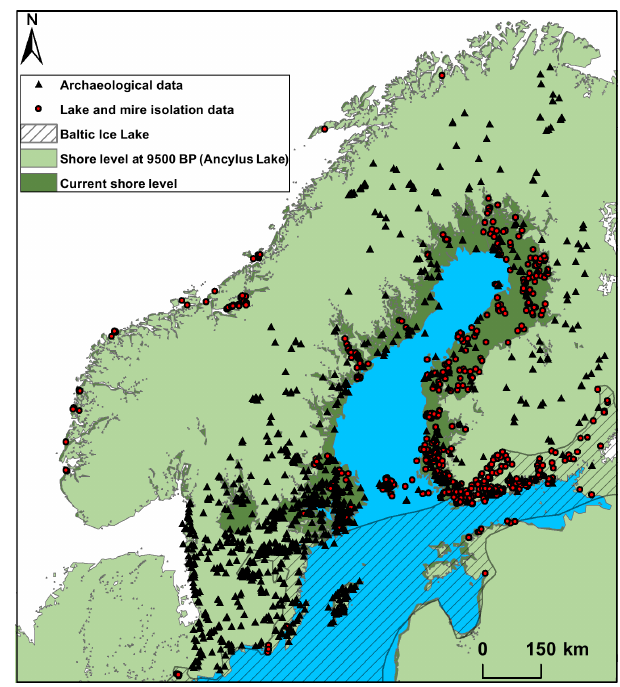
Figure 1. Spatial location of source data points. Maximum extent of the Ancylus Lake phase is indicated in dark green colour, and the Baltic Ice Lake area is marked by a hatched area. Data points: Po- hjola et al. (2019). Background map: © Esri. Historical shorelines: Geological Survey of